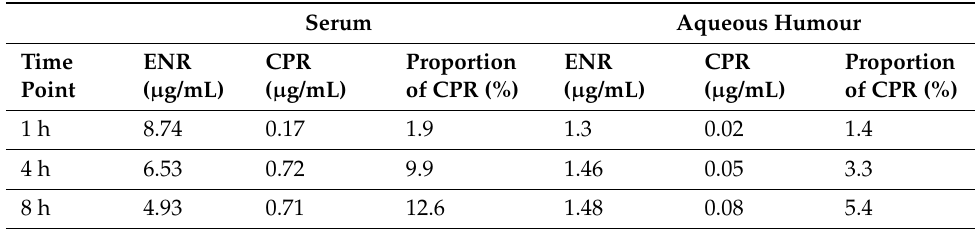
Table 2. Enrofloxacin (ENR) and ciprofloxacin (CPR) concentrations in serum and aqueous humour as measured using LC-MS/MS and the corresponding proportions of ciprofloxacin in the total amount of